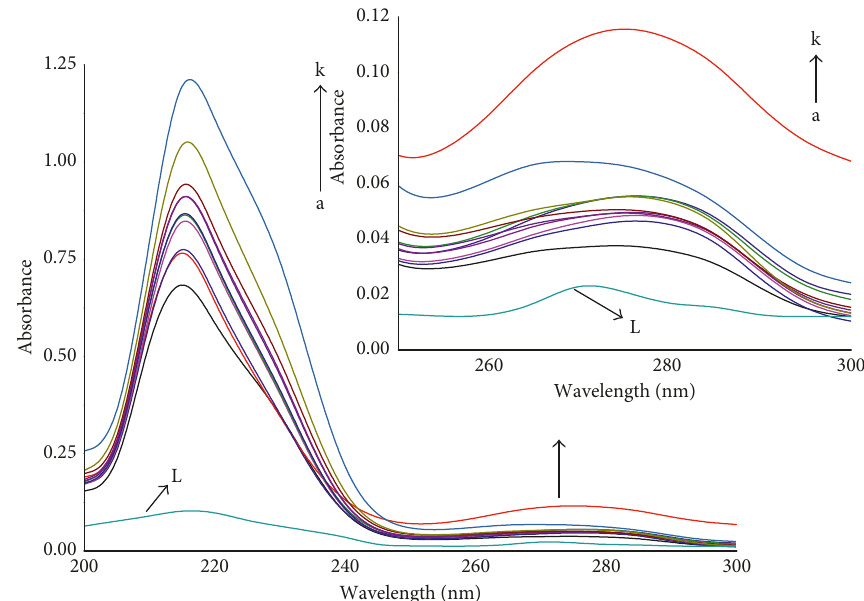
Figure 2: UV-Vis absorption spectra of BSA (2 . 5 × 10 − 6 mol · L − 1 ) with varying concentrations of RSN (0.5 to 5 . 5 × 10 − 6 mol · L − 1 ) with the addition of 0 . 5 × 10 − 6 mol · L − 1 in each step, and the curve L represents RSN only (2 . 5 × 10 − 6 mol · L − 1 ) at 297K and pH